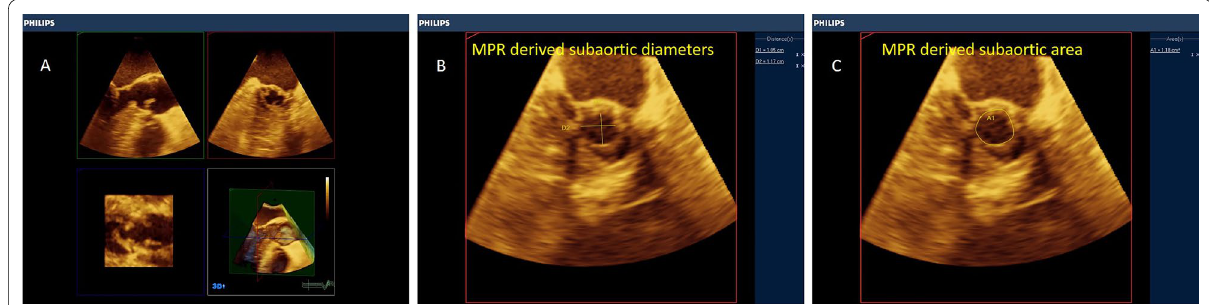
Fig. 7 Multiplanar reformatting (MPR) of the 3D volume of a subaortic membrane. (panel A ) Maximum diameters and planimetered area of the LVOT at the subaortic membrane (Panel B , C )